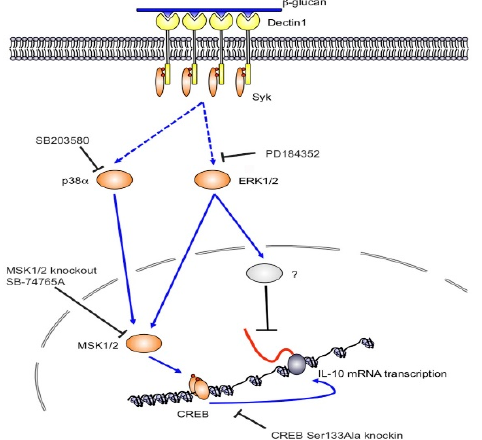
Figure 2. ERK1/2 regulate IL-10 transcription via MSK1/2 dependent and independent mechanisms. Dectin-1 is activated by complex β -glucan containing particles that induce clustering of dectin-1